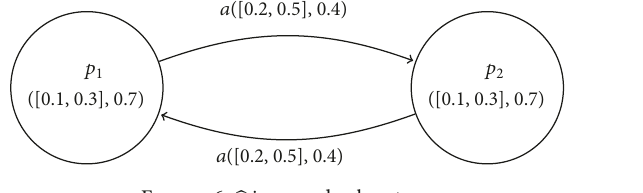
Figure 9: ̂𝜑 is a good subsystem.